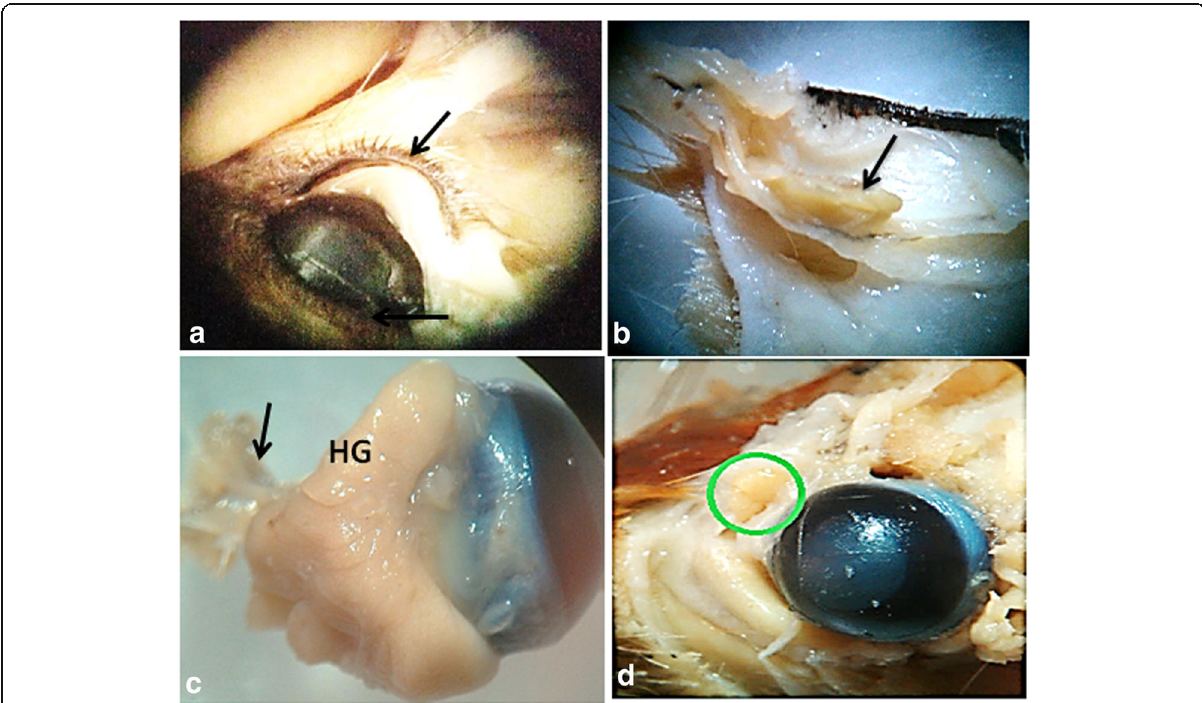
Fig. 1 Macroanatomy of the ocular glands and eyelids of Gerbillus tarabuli . a The upper eyelid (arrow). b The lower eyelid with Meibomium glands (arrow). c Lateral view of the gerbil eye, showing the location, lobulation, and color of HG; the third eyelid is attached to HG (arrow). d Lacrimal gland position (green circle), shape and